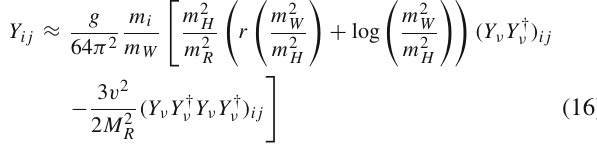
tively. The orange (light orange) contours are the corresponding 1(2)- sigma allowed ranges of cos (α − β) by the ATLAS measurement of the H → b ¯ b signal strength [96] with λ b = 1 (left) and 0.5 (right). See text for